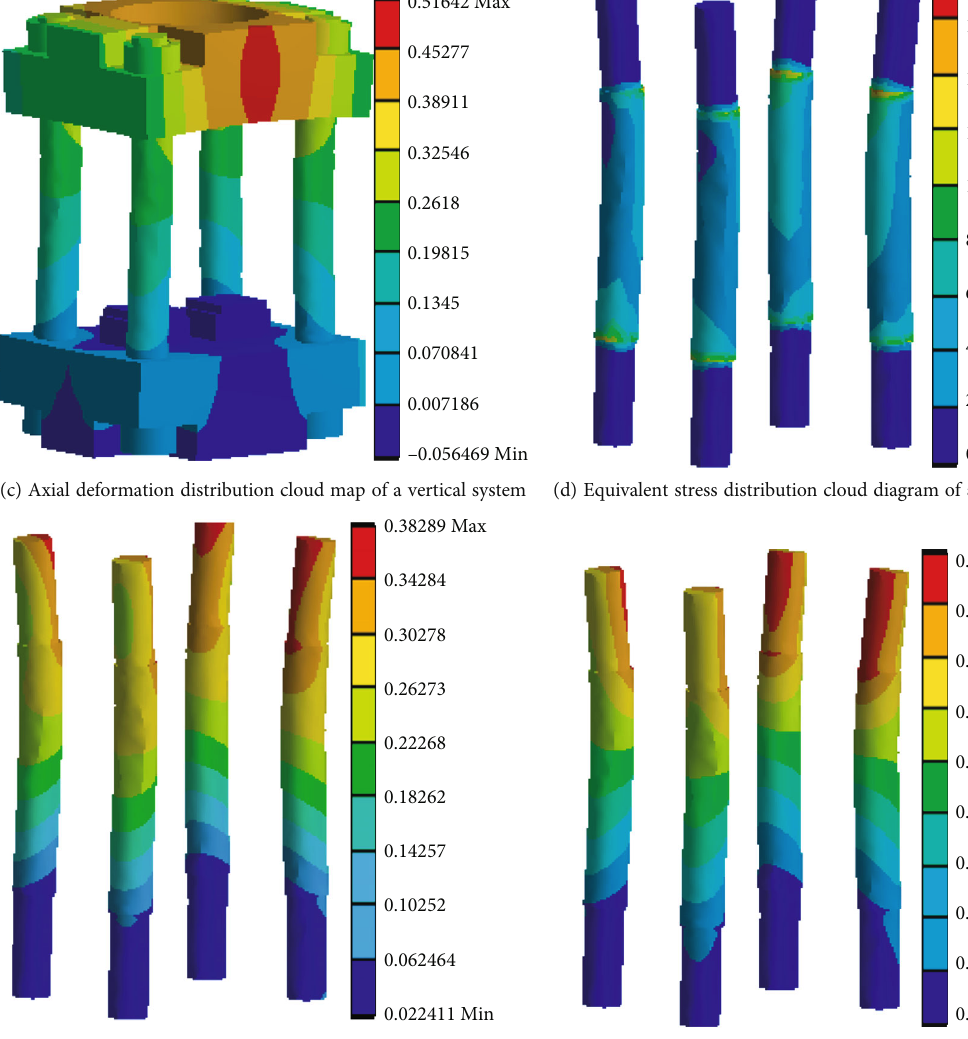
Figure 9: Numerical simulation results of vertical shear